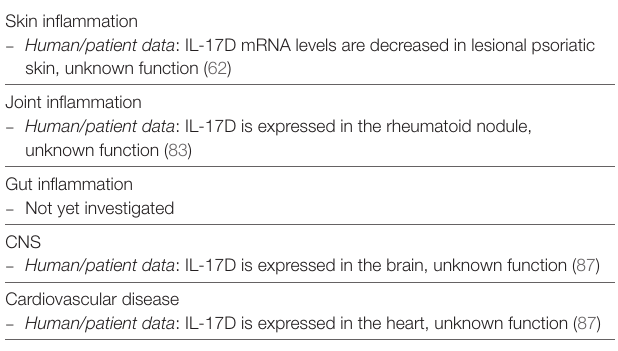
TABLe 4 | Overview of the role exerted by IL-17D in inflammation. Skin